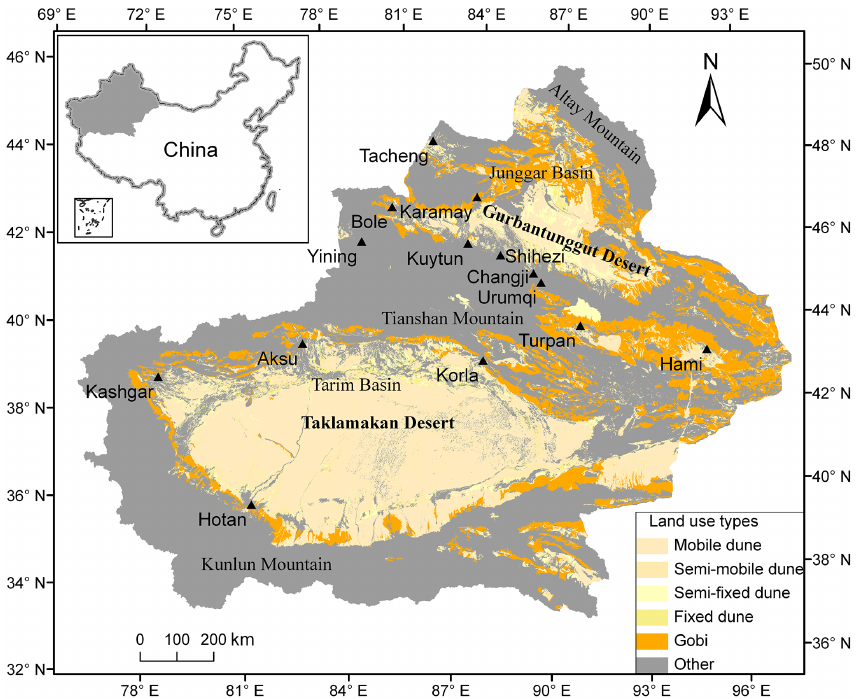
Figure 1. Location of Xinjiang Province in China (gray area outlined on inset map). Dust deposition and concentrations were measured at stations signified by small triangles. Land use types are identified across the province according to Wang et al.